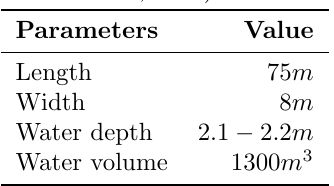
Table 2: Main parameters of the Aker Arctic ice basin (Wilkman et al.,